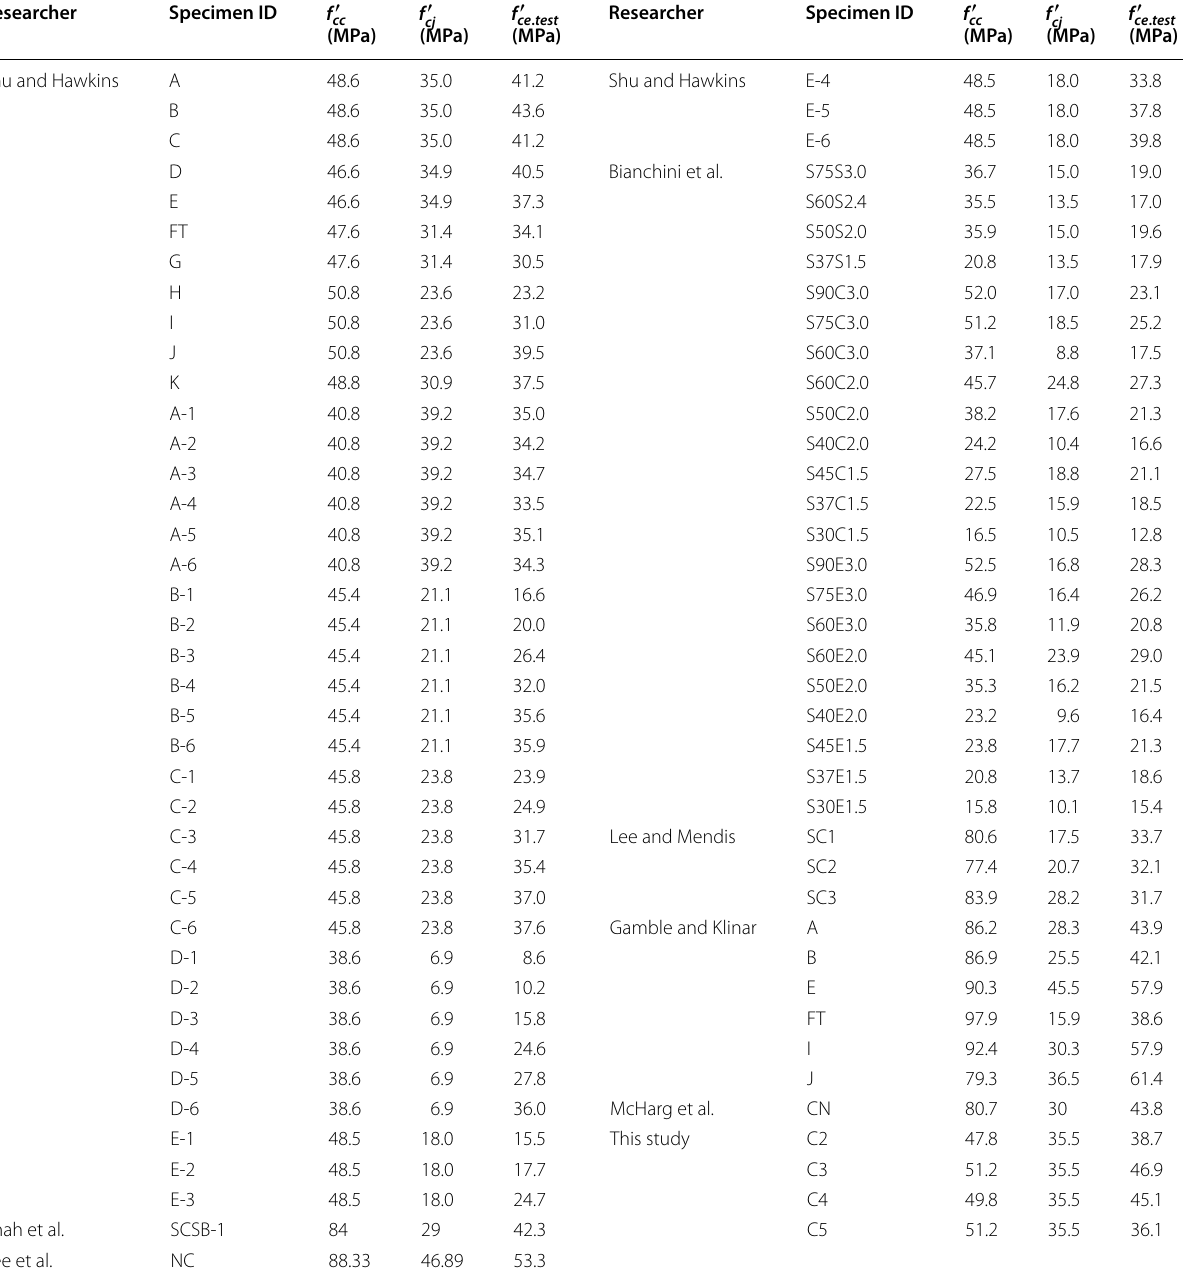
Table 3 Summary of corner and exterior column test